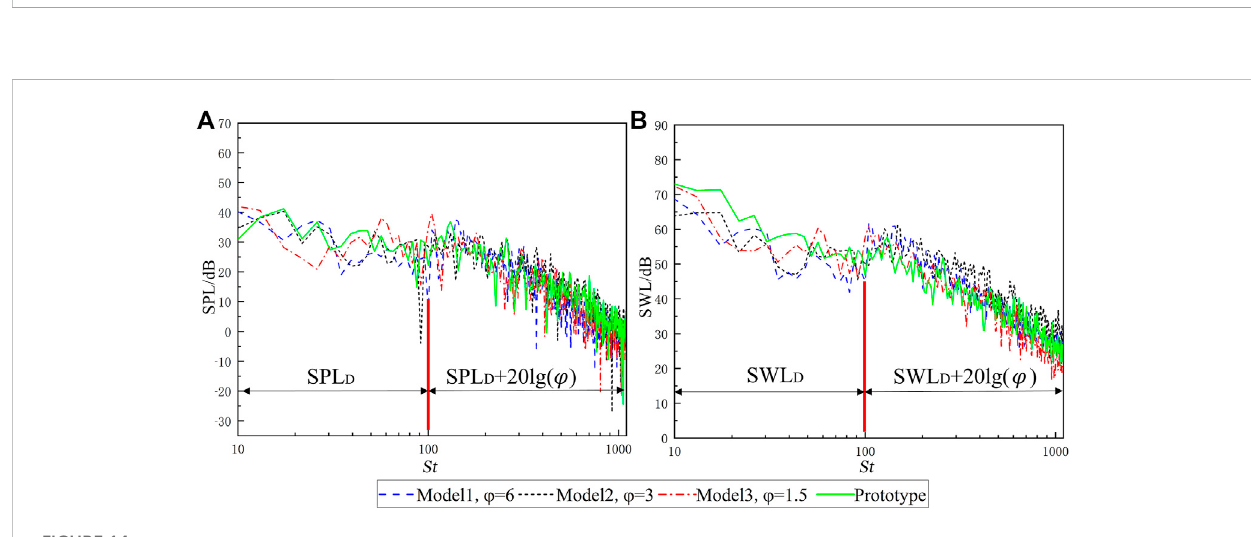
Comparison between extrapolated results which added the modi fi ed value and hypothetical prototype. (A) SPL of the 90 ° mearing point. (B) SWL of the ISO3744 mearing